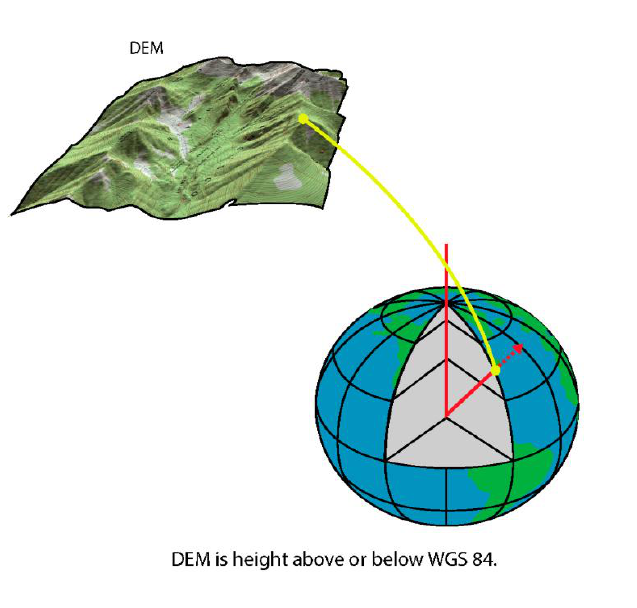
Figure 2. Illustration of how a digital elevation map (DEM) is superimposed on the Geoid to form a 3D surface that can be facetized to form a “scene” in Digital Imaging and Remote Sensing Image Generation